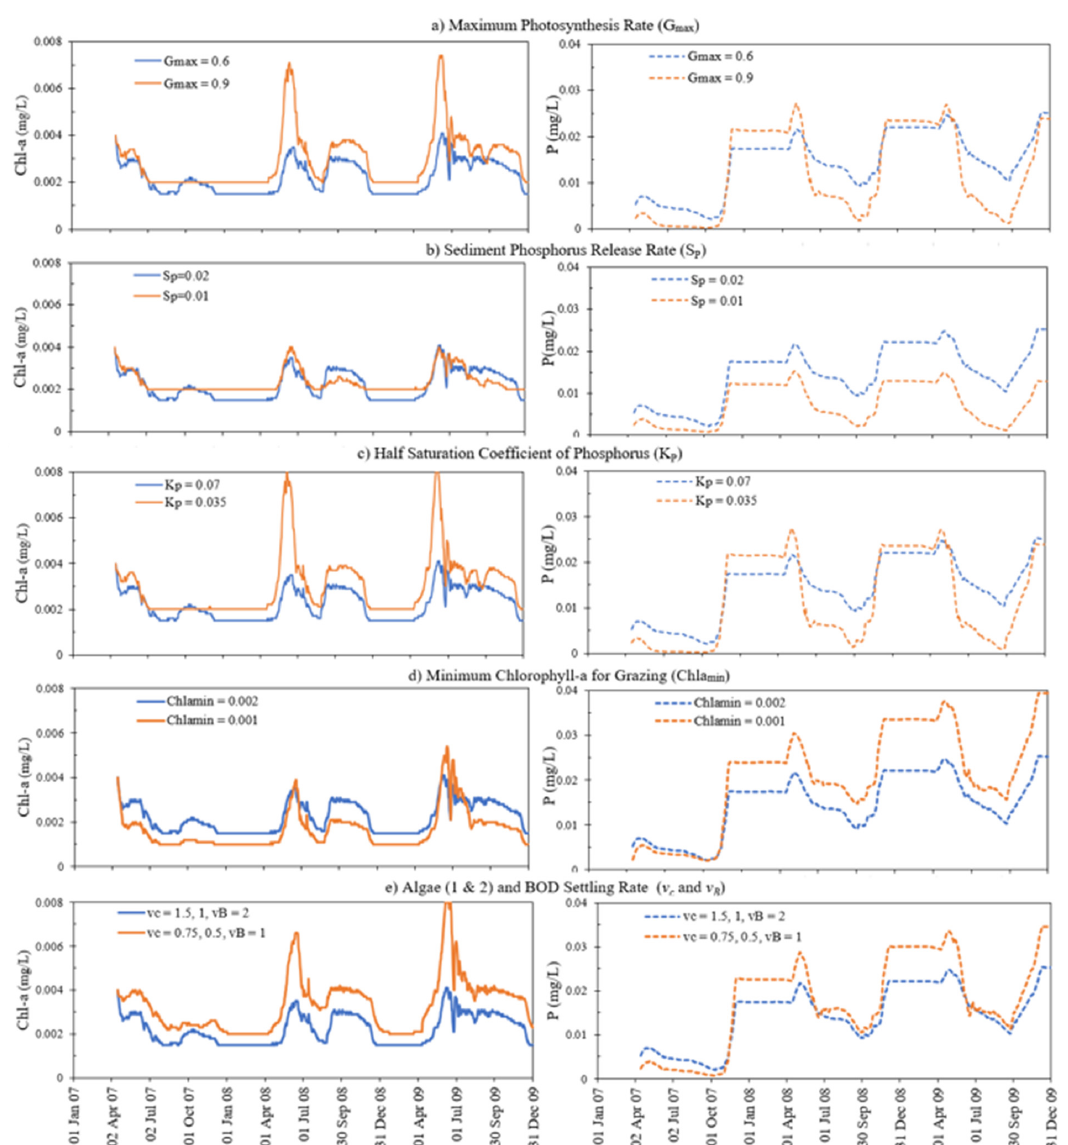
Figure 15. Sensitivity analysis of Chl a ( left panels ) and phosphorus ( right panels ) on ( a ) maximum photosynthesis rate G max , ( b ) sediment phosphorus release rate S P , ( c ) half saturation coefficient of phosphorus K P , ( d ) minimum Chl a for grazing Chla min , and ( e ) algae and BOD settling rates v c , and v B for simulation of Elmo Lake in 2007–2009.